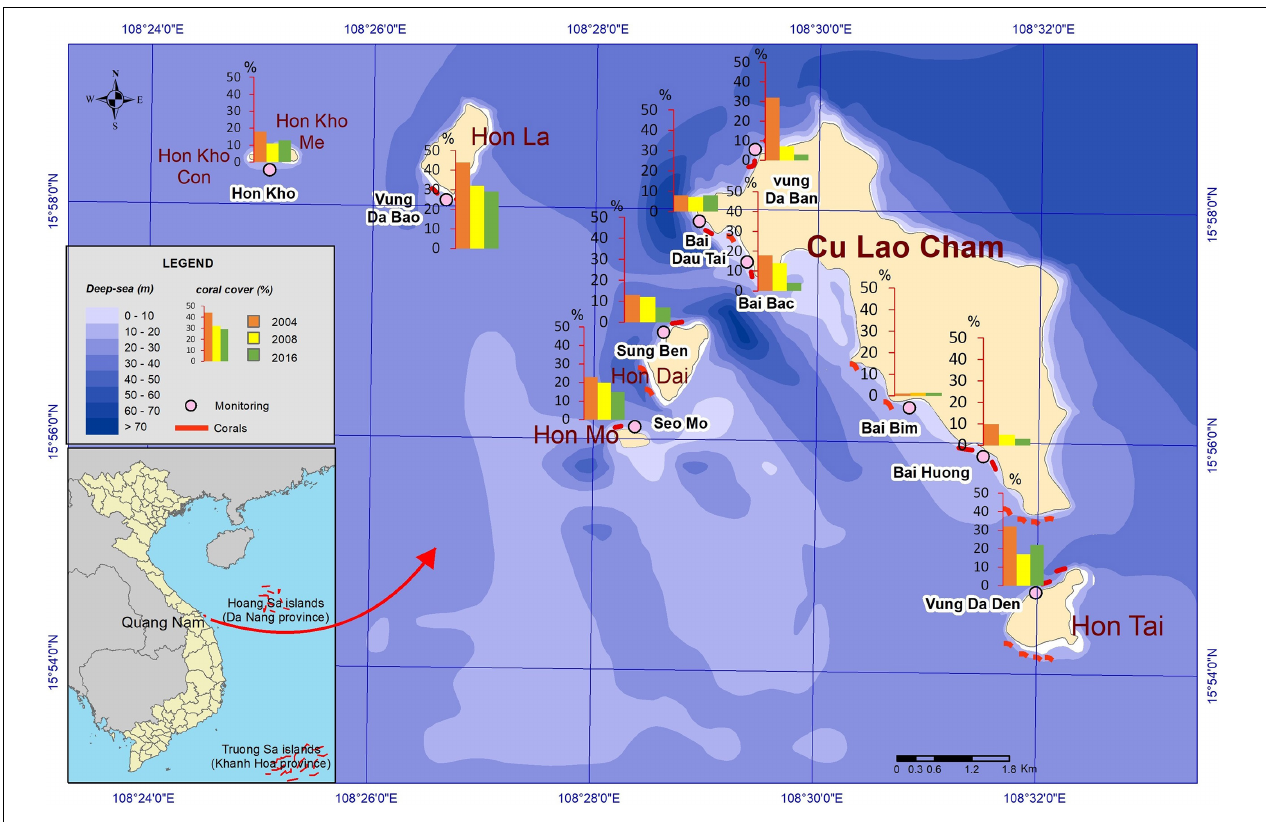
FIGURE 1 | The fluctuation of hard coral cover at monitoring sites by the time (Source data: Nguyen Van Long, 2017, pp.